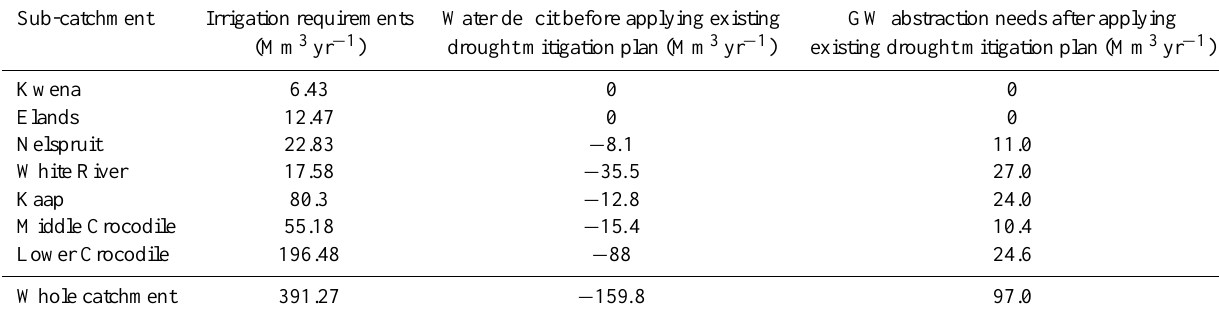
Figure 9. Water available versus water demand for the whole catchment. Table 5. Irrigation water requirements and water deficit per sub-catchment for the 1992–1995